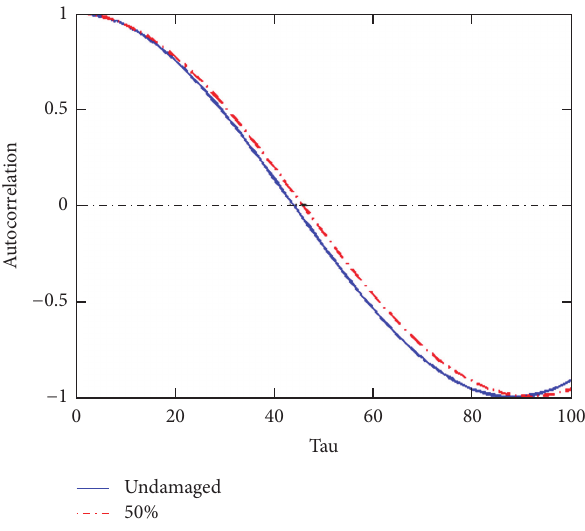
Figure 9: Phase spaces of the scenario with mass is 200 Kg and velocity is 1m/s: blue curve is for undamaged condition and red curve is for the 50% damaged